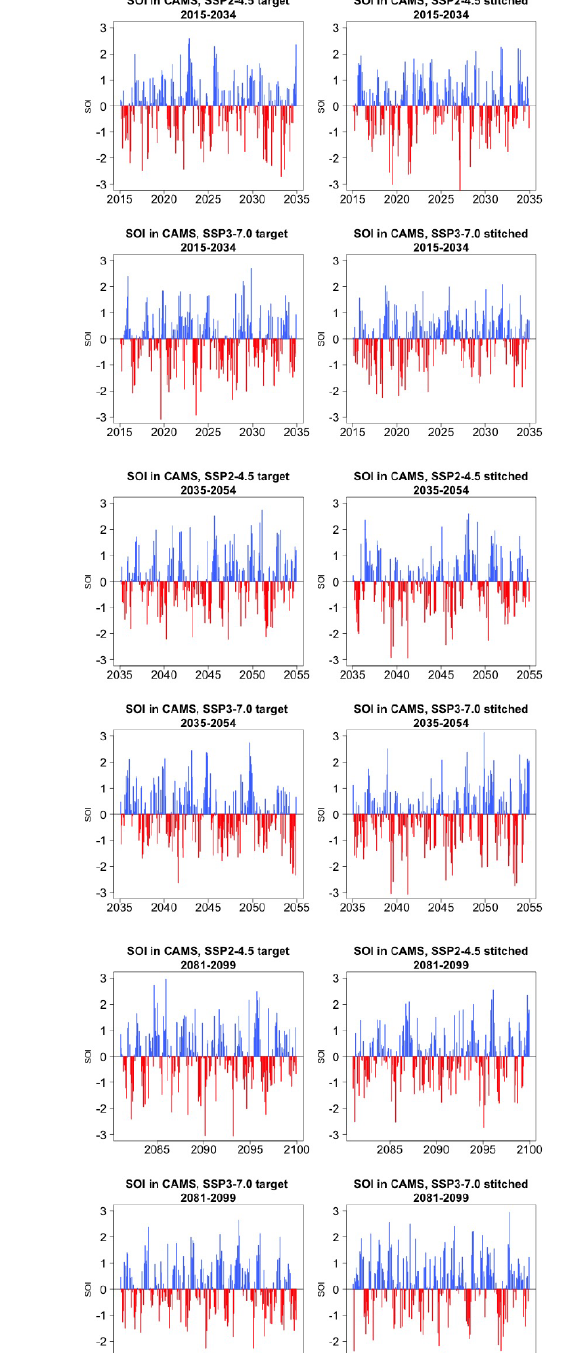
Figure 5. Examples of target (left) and stitched (right) SOI time series for three 20-year windows along the length of the simulation: 2015–2034 in the top four panels, 2035–2054 in the middle four panels, 2081–2100 in the bottom four panels. Results from emula- tion of SSP2-4.5 and SSP3-7.0 for CAMS-CM1-0.